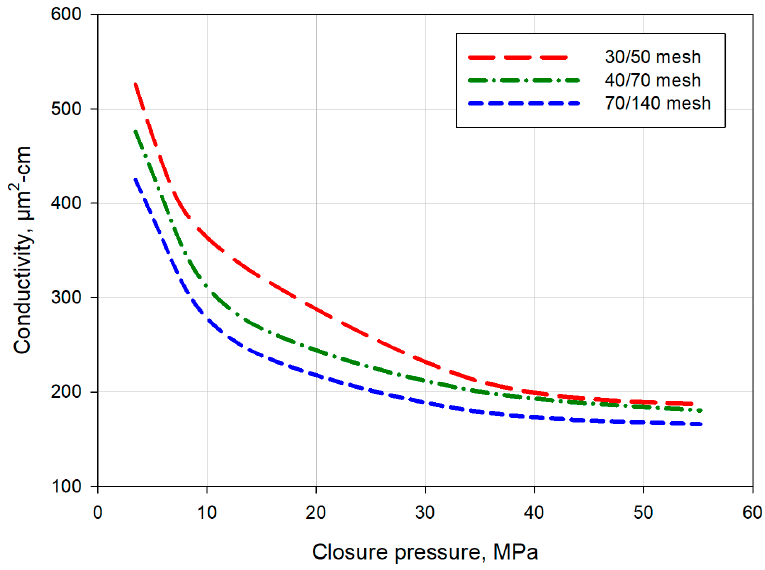
Figure 9. Conductivity evolution of cruciform intersecting pattern fractures with different sizes of proppants.